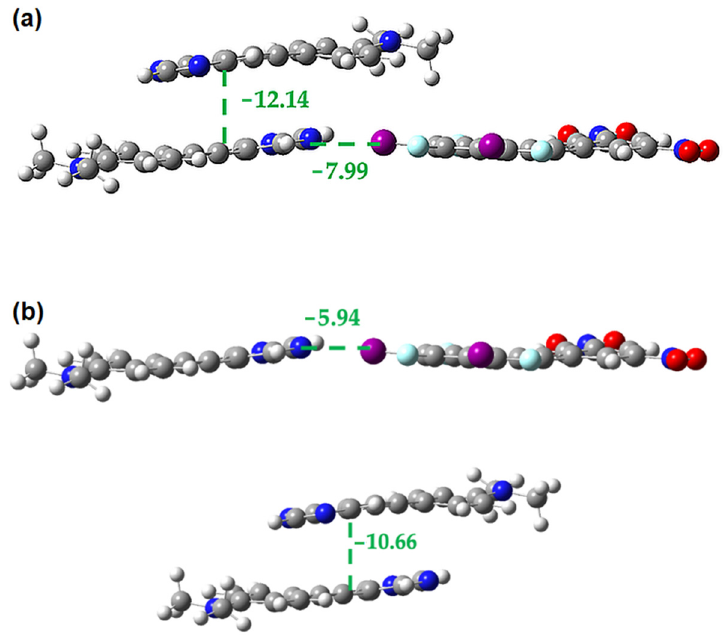
Figure 17. M062X-D3/DGDZVP interaction energies (in kcal/mol) in the 1 • 3 cocrystal for the interplay between 1-1 π -stacking and halogen bonding ( a ) within trimer ( b ) in the isolated dimers.